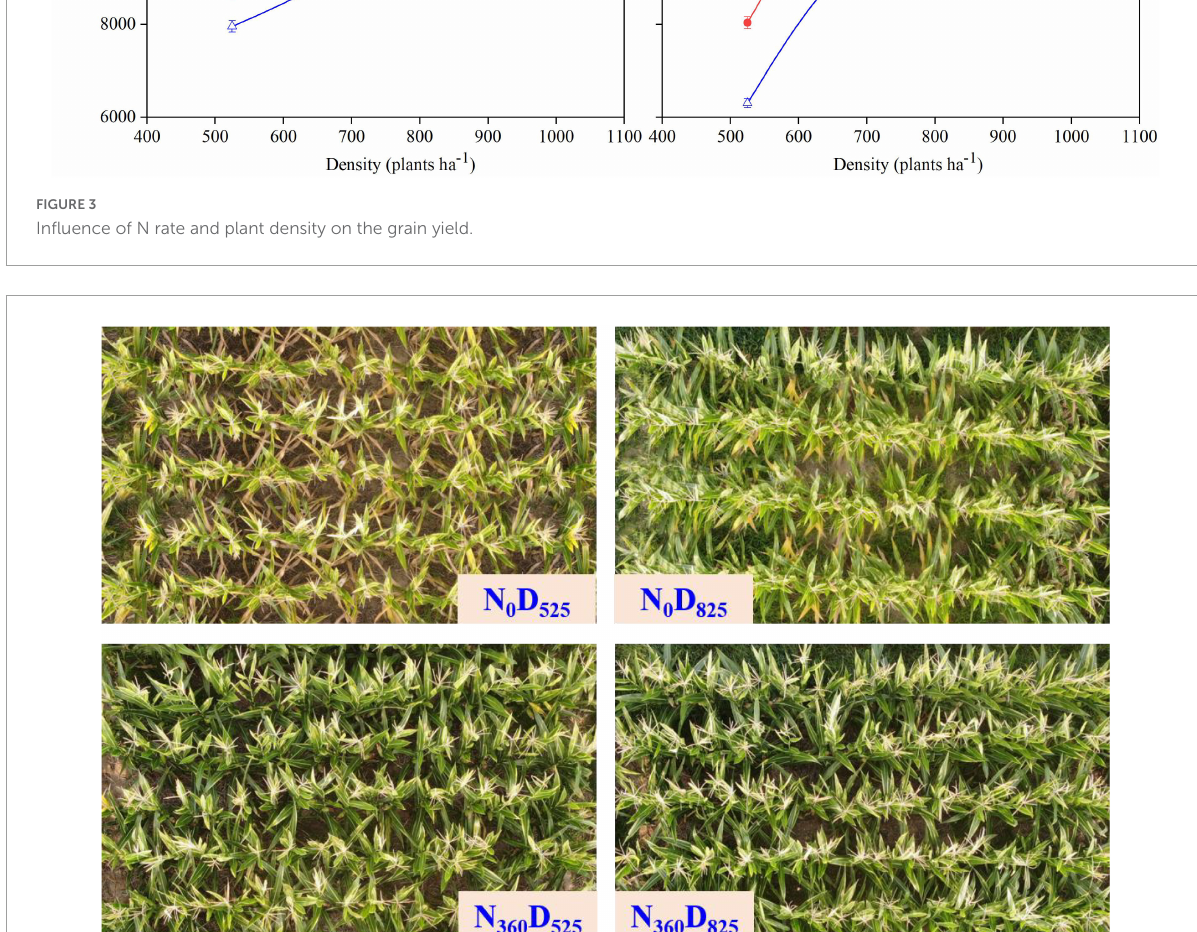
FIGURE4 Top view of different nitrogen input and plant density treatments on leaf development at the tasseling stage.